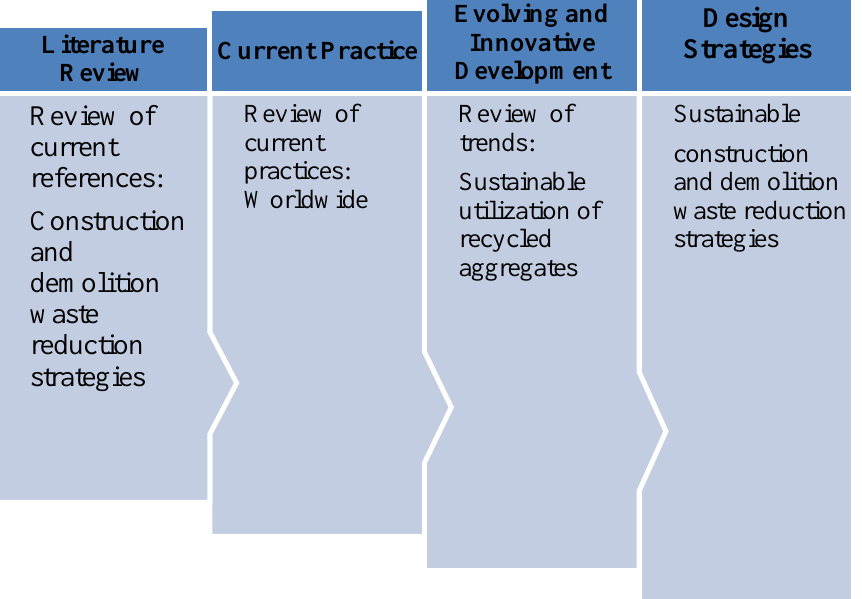
Figure 10. Research methodology of sustainable utilization of RCA.